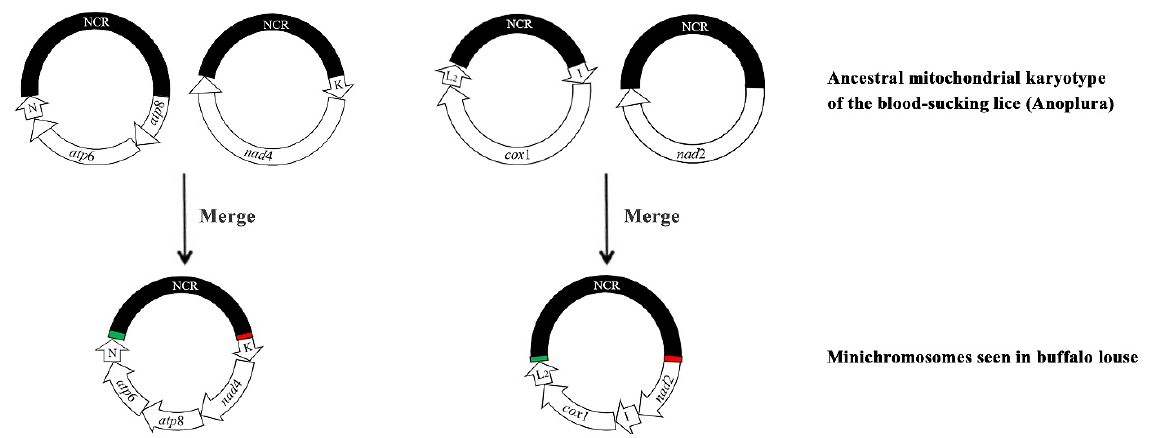
Figure 4. The ancestral mitochondrial minichromosomes of sucking lice that merges in Haematopinus tuberculatus . Gene name and transcription orientation are indicated in the coding region; non-coding regions (NCR) are in black. See Figure 1 legend for gene name abbreviation. Ancestral mt minichromosomes are inferred by Shao et al., 2017.